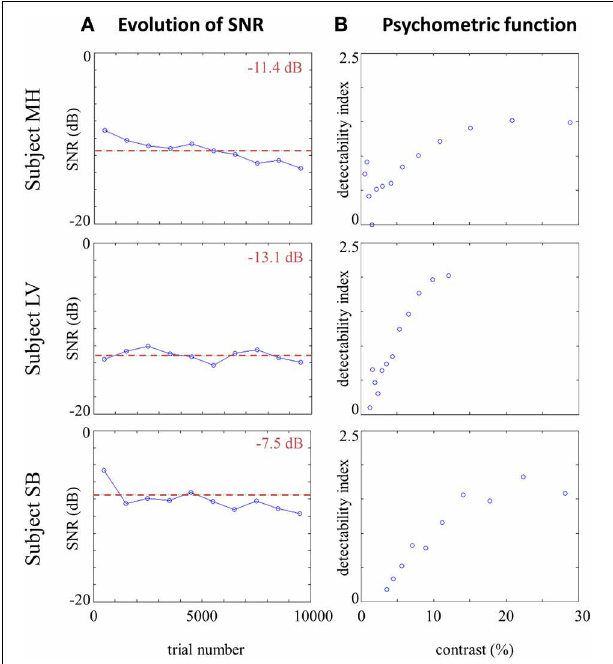
FIGURE 3 | Prediction accuracy of the model (in terms of 10-fold cross-validation rate) as a function of regularization parameters λ 1 (x-axis) and λ 2 (y-axis) in logarithmic scale, for one participant (MH). Around are shown classification images obtained with different pairs of regularization parameters ( λ 1 , λ 2 ) ( n = 10000 trials for each